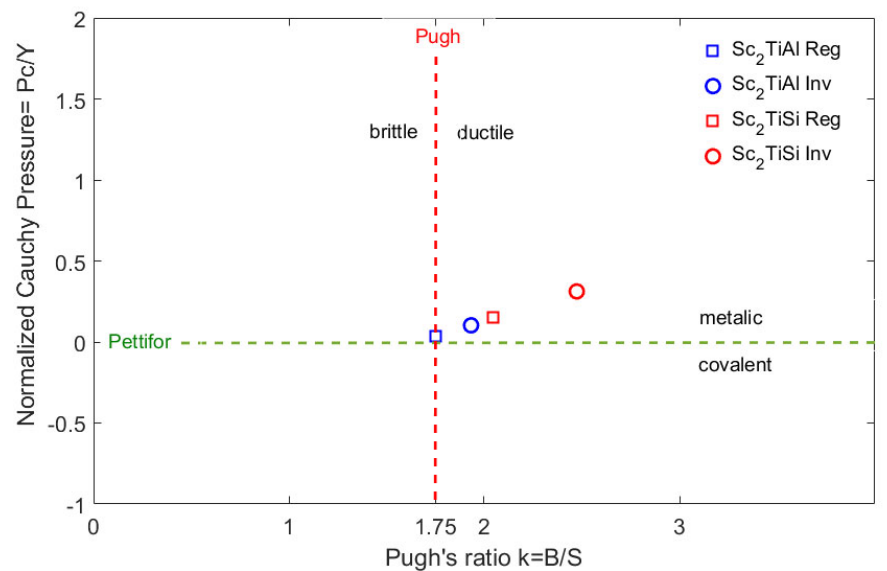
Figure 8. Ductile–brittle diagram for the studied compounds. The horizontal dashed line corre- sponds to the metallic-covalent criteria of Pettiford, and the vertical dashed line corresponds to the brittleness–ductile criteria of